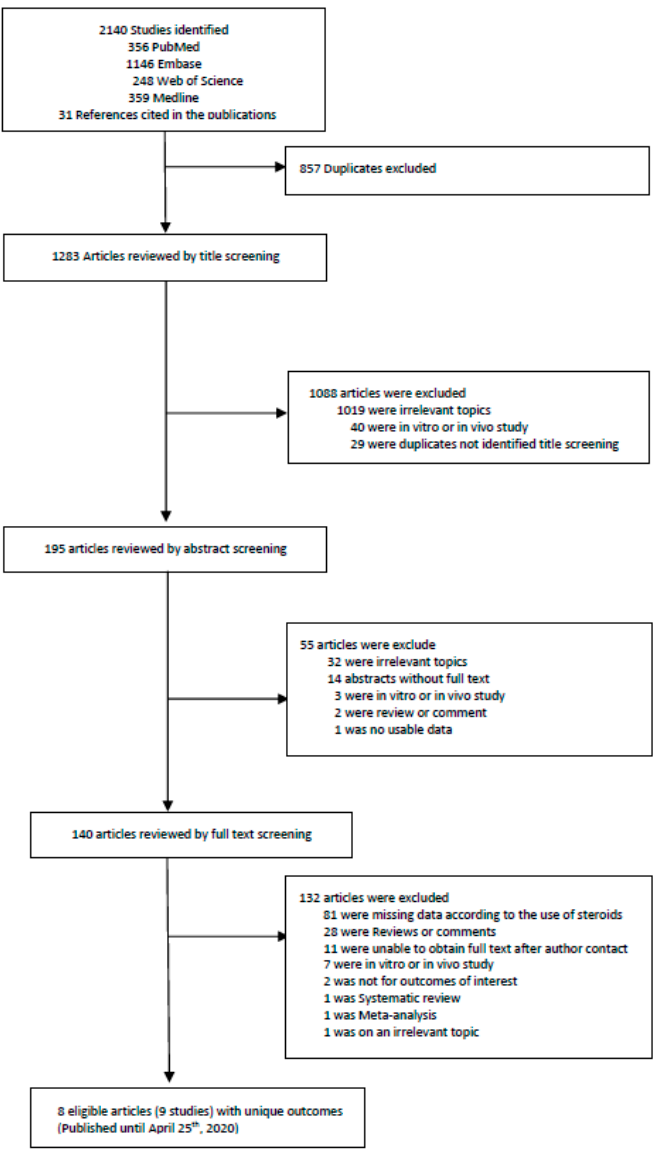
Figure 1. Flow chart of literature search.